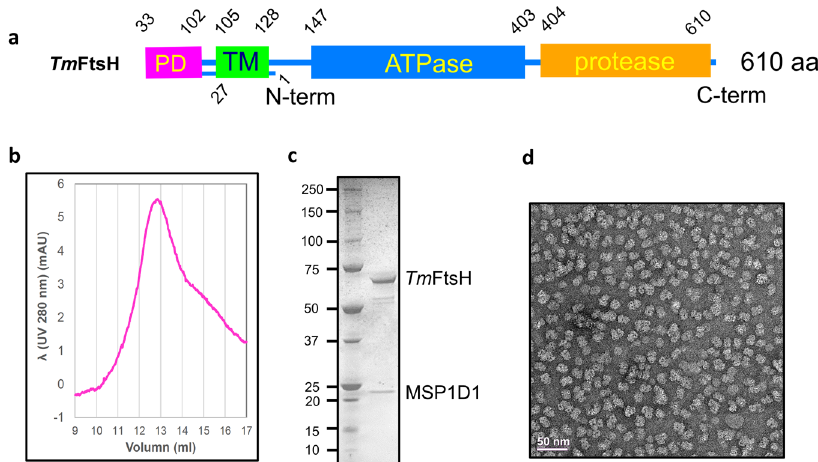
Fig. 1 Production and puri fi cation, and characterization of Tm FtsH. a Schematic diagram of Tm FtsH domains. PD periplasmic domain; TM transmembrane. b Size-exclusion chromatography and c SDS-PAGE analysis for the puri fi ed Tm FtsH in MSP1D1 nanodiscs. d Negative-staining micrograph of Tm FtsH reconstituted in MSP1D1